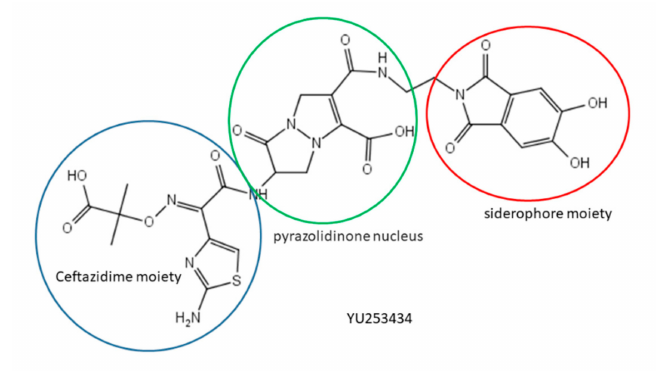
Figure 10. Structure of YU253434.